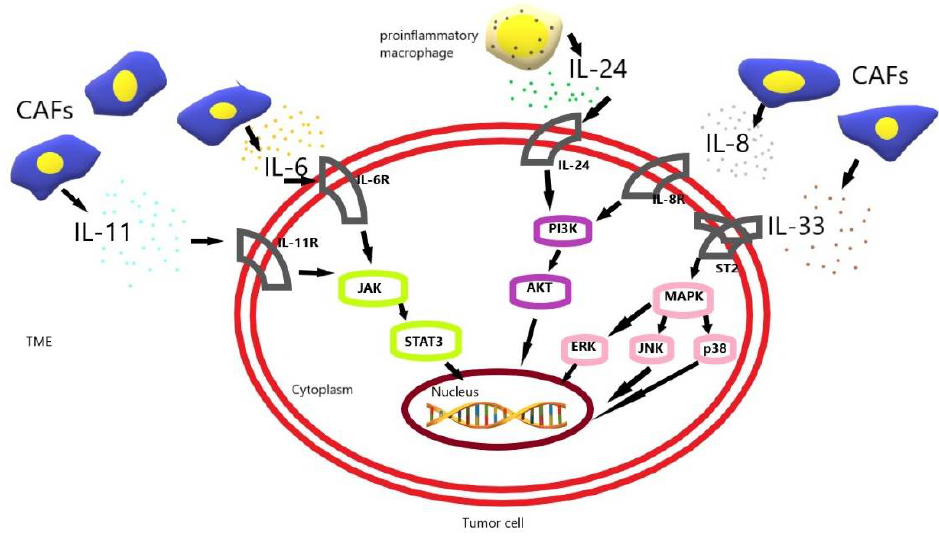
Figure 1. The schematic diagram of drug resistance development induced by IL-6, IL-8, IL-11, IL-24, IL-33 in gastric cancer cells [23,30,37,45,52]. CAF, cancer-associated fibroblast; TME, tumor micro- environment.